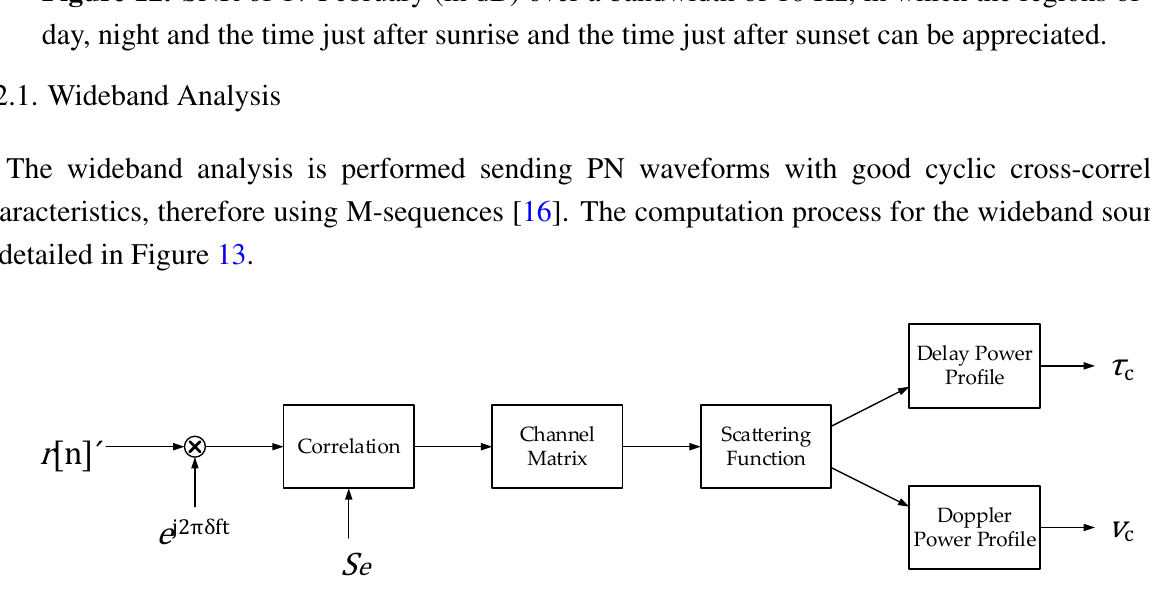
Figure 13. Diagram of the computation process for wideband channel